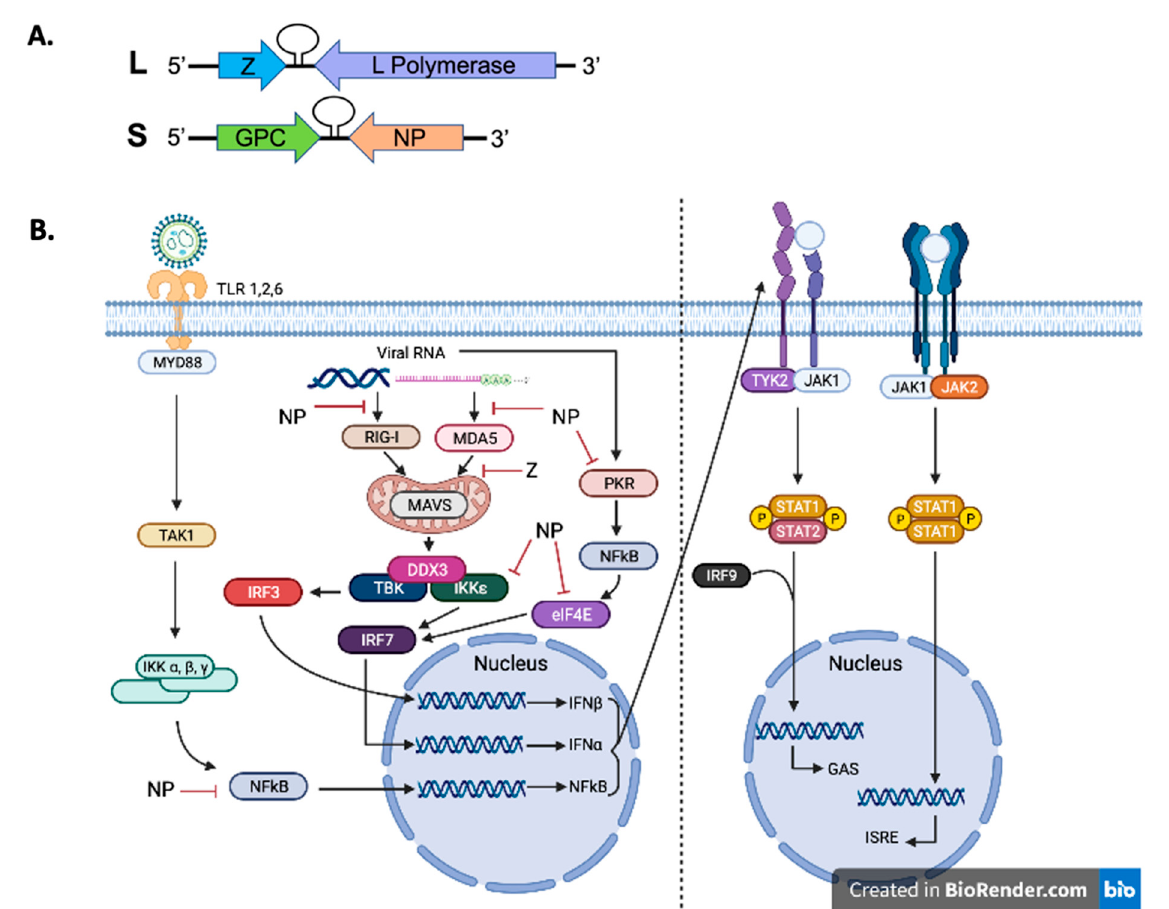
Figure 1. Arenaviral RNA genome structure and inhibition of innate immunity. ( A ) The genome of arenaviruses (e.g., LASV) is bisegmented and contained two genomic RNA segments that encode for four viral proteins in an ambisense coding strategy. Each of the segments have two open reading frames that encode for two gene proteins and is separated by a noncoding intergenic region (IGR). The IGR forms a stable hairpin RNA structure(s). The L segment (~7.2 kb) encodes for the L protein and Z protein. The S segment (~3.5 kb) encodes for the viral glycoprotein complex (GPC) and NP proteins. (B) The cellular Toll-like receptors (TLRs) recognize pathogen-associated molecular patterns (PAMPS), for example viral glycoproteins, and utilize the MYD88 adaptor protein to transmit cellular signals to influence the activities of other cellular proteins (e.g., TAK1, IKKa, β , and γ in order to activate transcription factors (e.g., interferon regulatory factors–IRF3 and 7) and NFkB subunits to induce the expression of IFNa and IFNb. To further activate other protein kinases (like TYK2, JAK1, and JAK2) and transcription factors (like STAT1 and STAT2 by phosphorylation), IFNa and IFNb are secreted from the cells and bind to their receptors on the membrane surface of cells. This causes the translocation of transcription factors (e.g., STAT1 and STAT2) from the cytoplasm into the nucleus, where they activate the transcription of hundreds of antiviral genes through their promoters (e.g., GAS or ISRE). On the other hand, aberrantly generated viral double-stranded RNAs (dsRNAs) are recognized as PAMPs by intracellular receptors, such as RIG-1 and MDA5. These activated intracellular receptors then activate cellular proteins such as MAVS (mitochondria), DDX3, TBK, and IKKe, which in turn activate IRF3, 7, and NFkB transcription factors to upregulate IFNa and IFNb. Aberrantly generated dsRNAs can also activate PKR (another intracellular receptor), which in turn activates NFkB and affects the function of other cellular proteins like elF4E to increase the expression of IFNa and IFN.